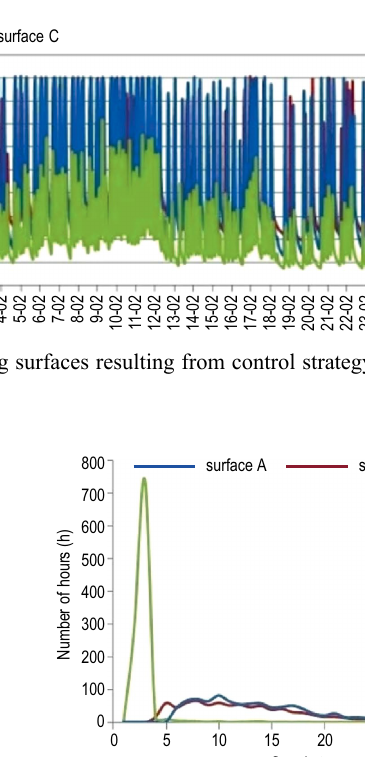
Fig. 11. Supply temperature for different heating surfaces resulting from control strategy t surf = 3 °C for investigated period